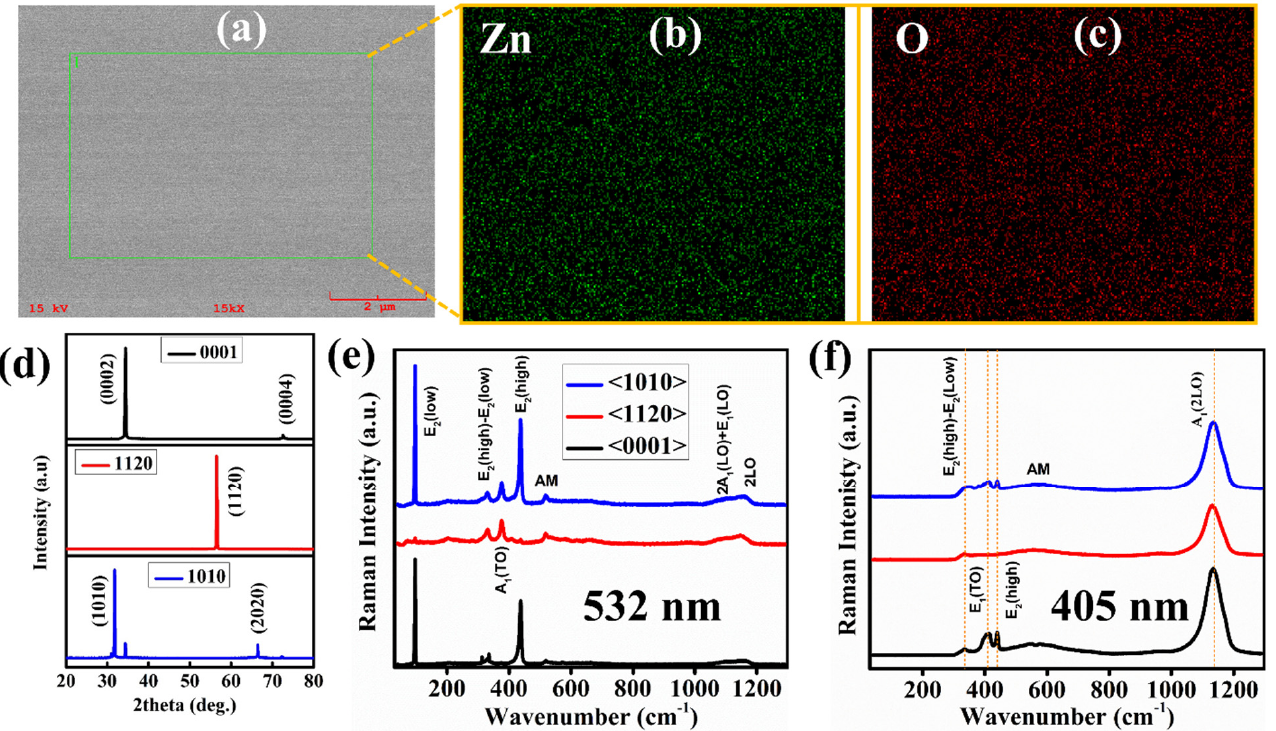
Figure 1. ( a – c ) Field-emission electron microscopy (FE-SEM) and energy dispersive spectroscopy (EDS) image of <0001> single crystal ( d ) XRD micrographs of all three ZnO single crystals <0001>, <1120> and <1010>. The Raman spectra of ZnO single crystals were measured with ( e ) an excitation wavelength of 532 nm and ( f ) 405 nm. Table 1. Summary of Raman vibrational modes in the literature and observed in current study for ZnO single crystals with polar and non-polar faces.